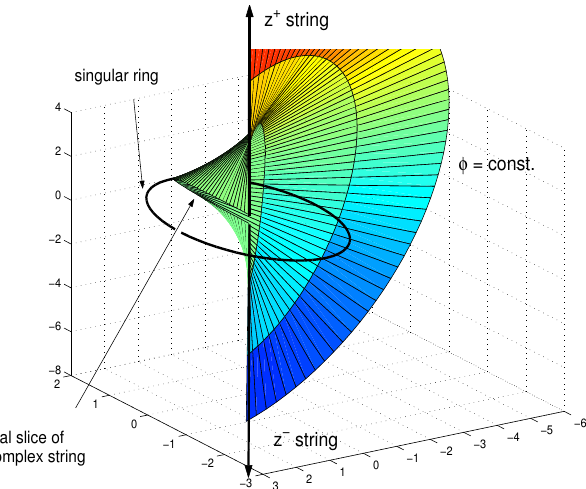
Figure 3. Deformations of the Kerr coordinate φ = const . caused by dragging of space in angular direction near the Kerr singular